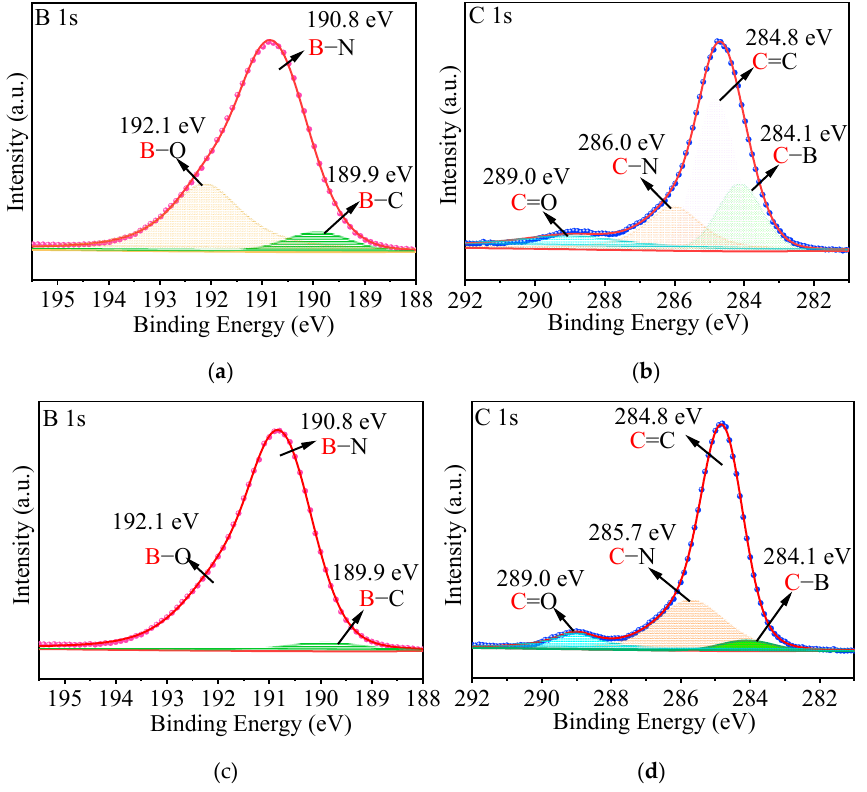
Figure 7. XPS high-resolved spectra of ( a ) B 1s and ( b ) C 1s of p-BCN-1 and ( c ) B 1s and ( d ) C 1s of p-BCN-2, respectively.